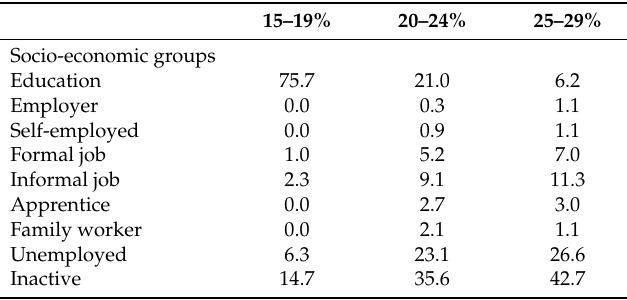
Table 8. Socio-economic groups by age, females (in percentages).